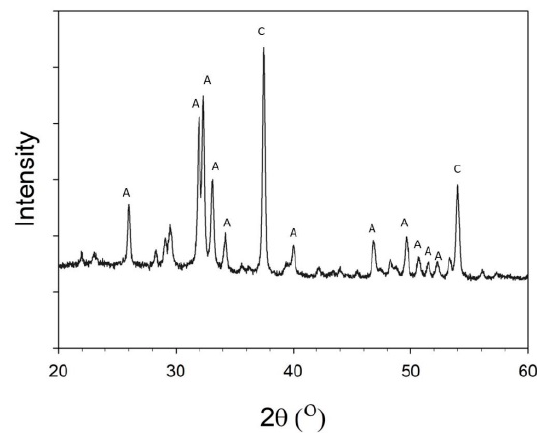
Figure 4. XRD pattern of the HANFs. (C: CaO, PDF 70-4068; A: HAp, PDF 84-1998).